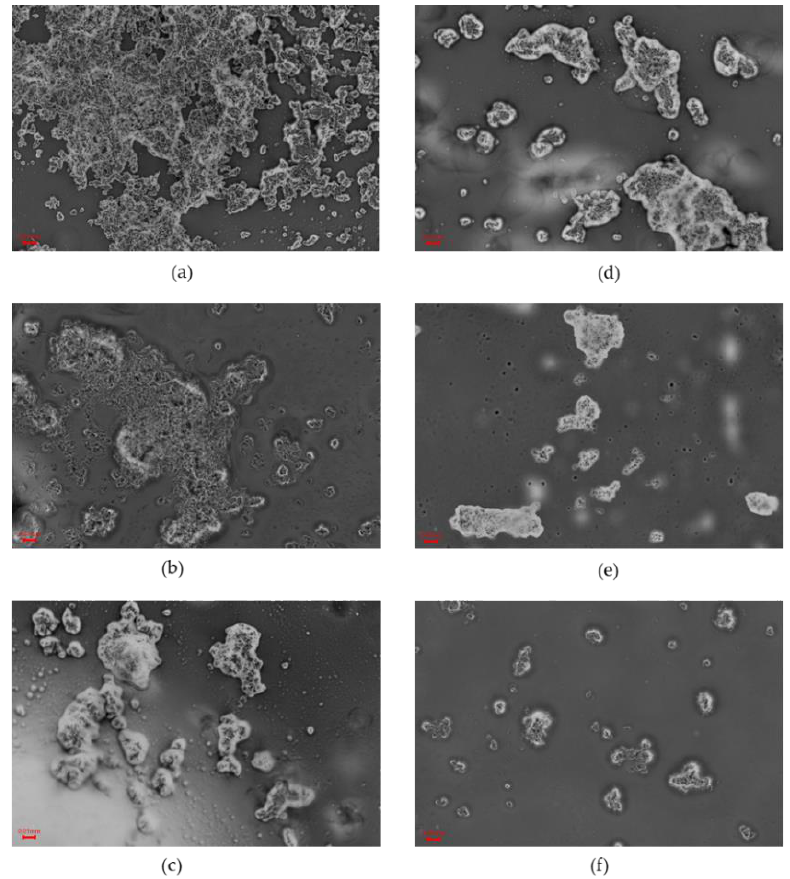
Figure 3. Microstructure of polymerized whey protein depending on the time of heat treatment. ( a – c ): single-heated polymerized whey protein after 10, 20, or 30 min, respectively; ( d – f ): double-heated polymerized whey protein after 10, 20, or 30 min, respectively; optical microscopy, 40× objective.